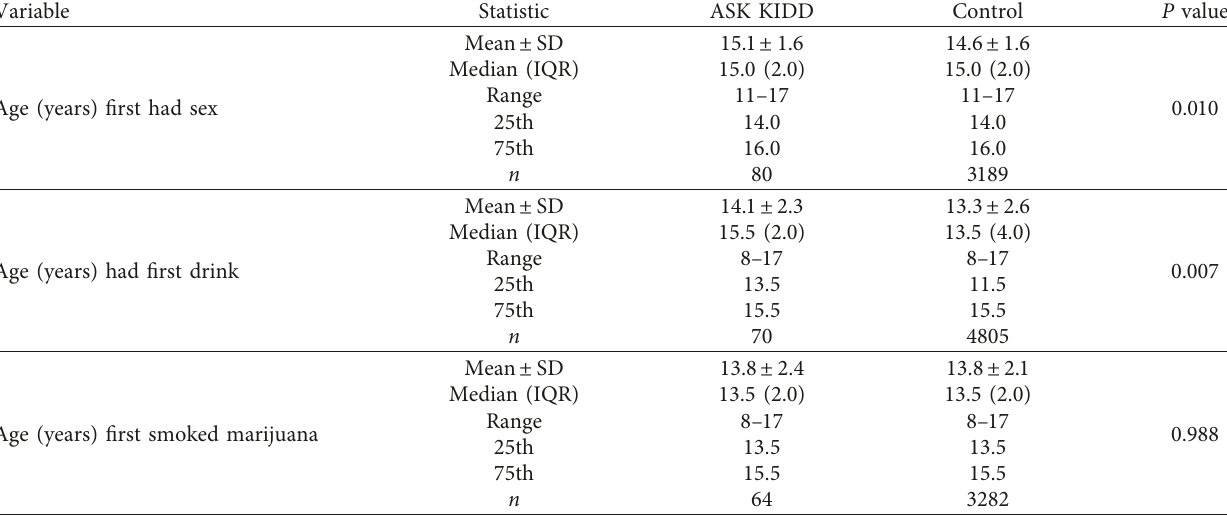
Table 4: Ages (years) for first had sex, first had a drink, and first smoked marijuana. Variable